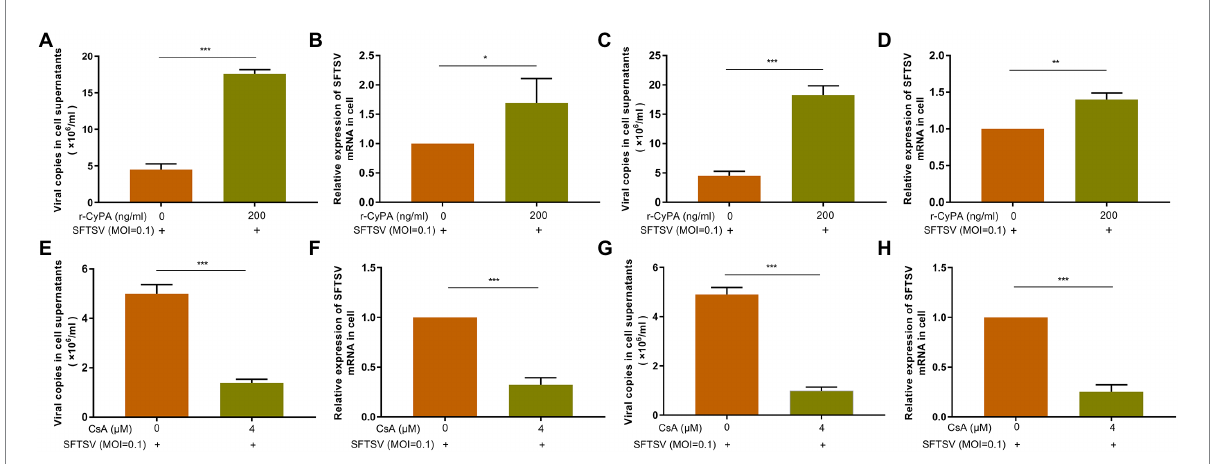
FIGURE 4 CyPA promotes the replication of SFTSV in THP-1 cells. In the experimental group, THP-1 cells were pretreated with hr-CyPA for 2 h and then infected with SFTSV for 48 h, after which the expression of SFTSV in the supernatant (A) and intracellular fluid (B) was determined. In the experimental group, THP-1 cells were infected with SFTSV for 2 h and then treated with hr-CyPA for 48 h, and the expression of SFTSV in the supernatant (C) and cells (D) was measured. In the experimental group, THP-1 cells were infected with SFTSV for 48 h after 2 h CsA pretreatment, and the expression of SFTSV in the supernatant (E) and intracellular fluid (F) was determined. In the experimental group, THP-1 cells were treated with CsA for 48 h after 2 h of SFTSV infection, and the expression of SFTSV in the supernatant (G) and cells (H) was measured. The values represent the mean ± standard error of three independent experiments. ** p < 0.01, *** p <